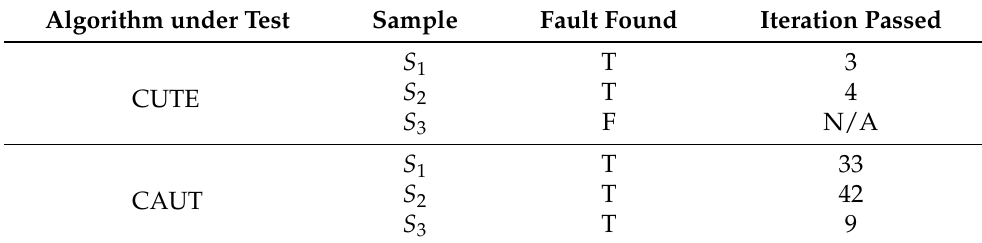
Table 5. Experiment results. Algorithm under